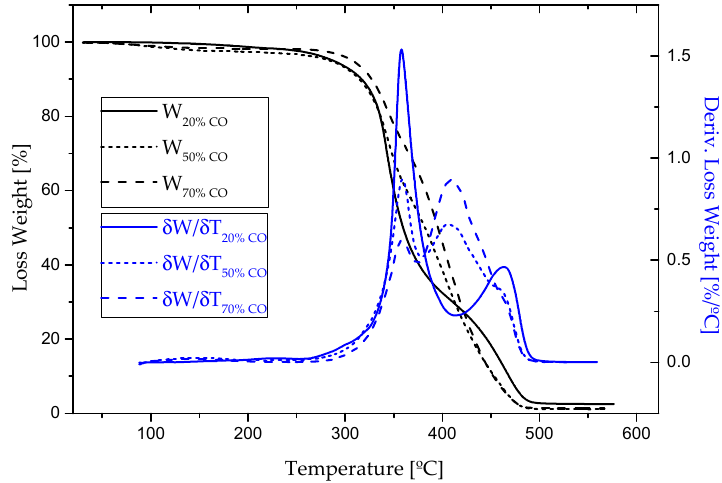
Figure 2. Thermogravimetric analysis (TGA) analysis for all bio-based adhesives.